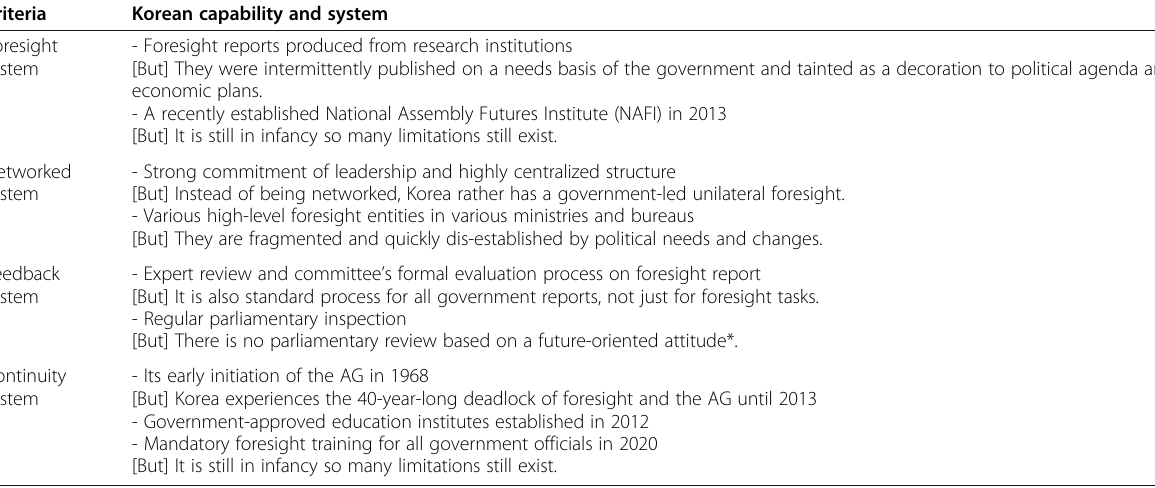
Table 6 Korea ’ s AG level under the new framework